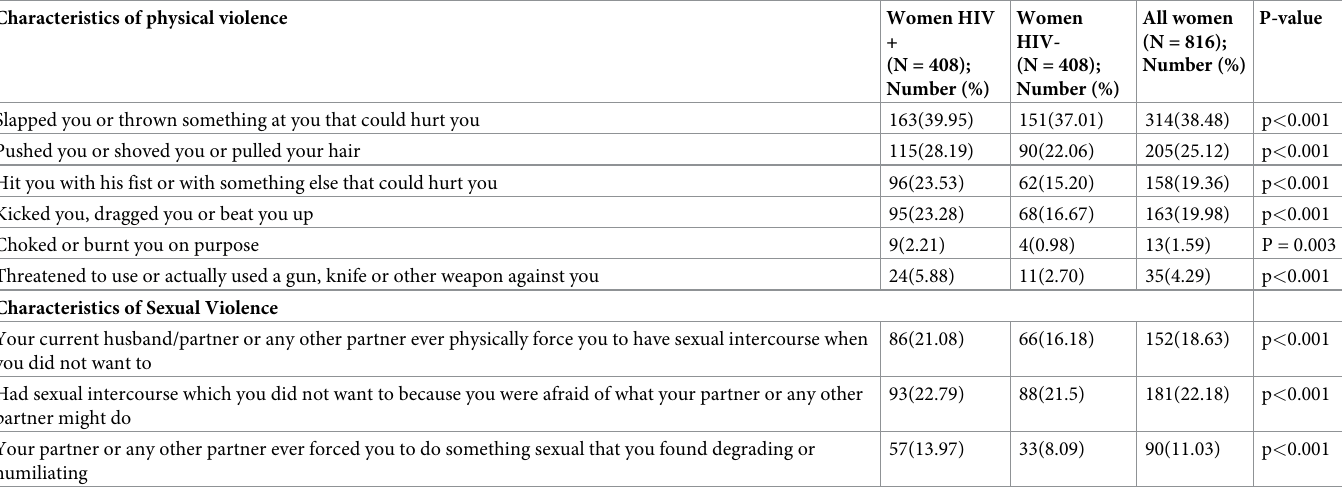
Table 3. Prevalence of lifetime physical and sexual violence among women living with and without HIV in Wolaita Zone, Ethiopia, November-December 2018. Characteristics of physical